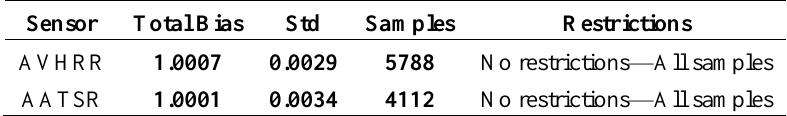
Table 6. Summary of results for all SNO match-up targets for the AVHRR-heritage channel at 11 µm based on inter-comparisons with MODIS on AQUA. The total bias is expressed as the relative bias ( i.e. , brightness temperature quota).